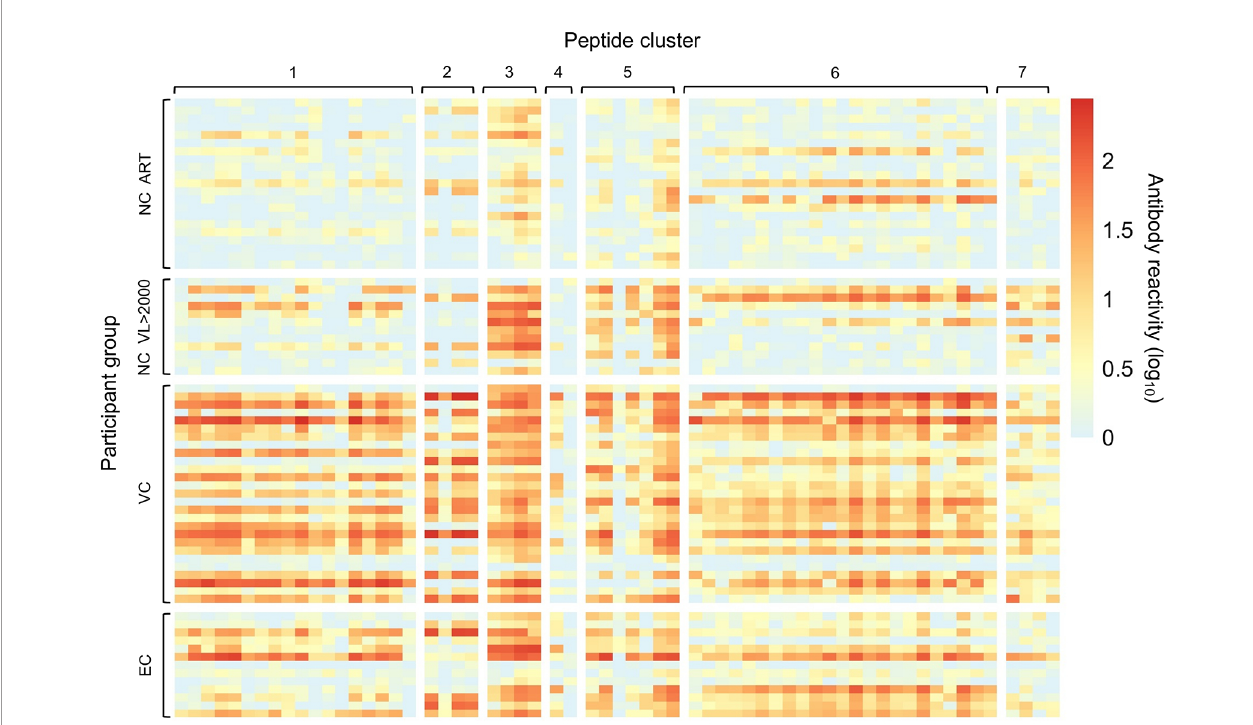
FIGURE 3 | Individual patterns of antibody reactivity to peptides in peptide clusters. The patterns of antibody reactivity are shown for the 13 individual elite controllers (EC), 27 viremic controllers (VC), 12 non-controllers with viral loads >2,000 copies/mL (NC VL >2000), and non-controllers who were virally suppressed on ART (NC ART). Colors indicate the level of antibody reactivity (log 10 fold change in VirScan read counts compared to mock immunoprecipitation reactions); values less than zero were assigned a value of zero. Each colored square represents data for a single peptide from a single individual. Darker colors indicate higher levels of antibody reactivity. Data are grouped by participant group and peptide cluster (see Table 2 ).